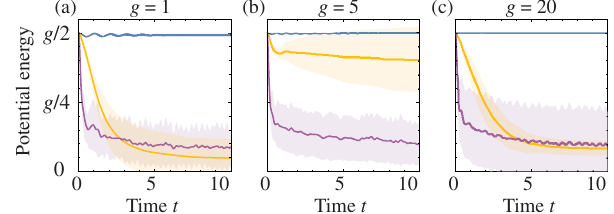
FIG. 5. Localization on a DBG quantum network (Video 4 in Supplemental Material [56]). (a) – (c), When the wave function in the Gross-Pitaevskii model of Eq. (4) is initialized at a weakly connected vertex with low kinetic energy, localization or delo- calization (indicated by high or low potential energy, respec- tively) is controlled by the interplay between the graph spectrum and the rate of potential energy loss g . The random graph (purple) always delocalizes, due to its dense spectrum. However, while the sparsified graph (yellow) can delocalize for low g (a) and high g (c), again due to available eigenmodes, intermediate g (b) places the range of allowed modes inside the spectral gap, preventing delocalization. The complete graph (blue) always inhibits spread- ing due to the extreme localization of its